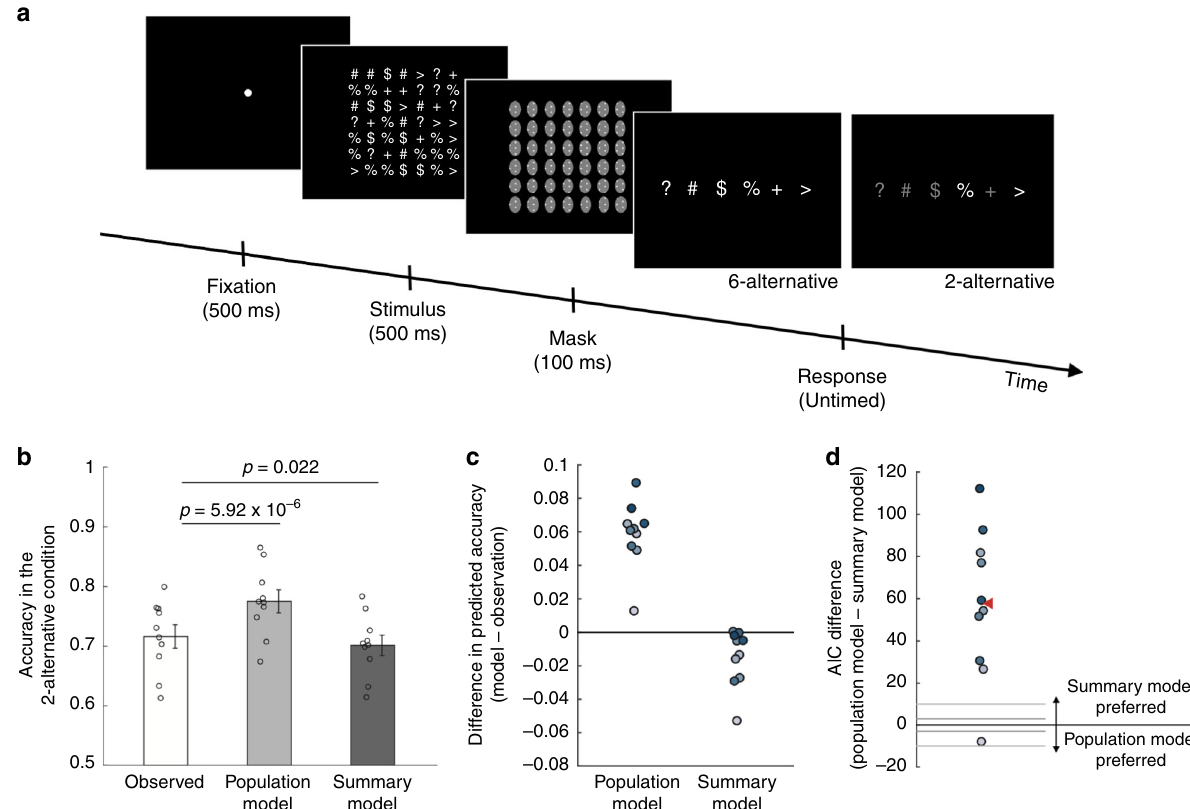
Fig. 5 Task and results for Experiment 2. a The task in Experiment 2 was similar to Experiment 1 except for using six different symbols (question mark, pound sign, dollar sign, percentage sign, plus sign, and greater-than sign) instead of four different colors. One of the symbols was presented more frequently (14 times, dominant symbol) than the others (7 times each, nondominant symbols) and the task was to indicate the dominant symbol. Two conditions were presented in different blocks: a six-alternative condition where subjects chose between all six symbols and a two-alternative condition where subjects were given a choice between the dominant and one randomly chosen nondominant symbol. b Mean accuracy in the two-alternative condition observed in the actual data (white bar) and predicted by the population (light gray bar) and summary (dark gray bar) models. The predictions for both models were derived based on the data in the six-alternative condition. All p values are derived from two-sided paired t tests. Error bars represent SEM, n = 10. c Individual subjects ’ differences in the accuracy of the two-alternative condition between the two models and the observed data. d AIC difference between the population and the summary models. Positive AIC values indicate that the summary model provides a better fi t to the data. Each dot represents one subject. The red triangle indicates the average AIC difference. The summary model provided a better fi t than the population model for nine out of ten